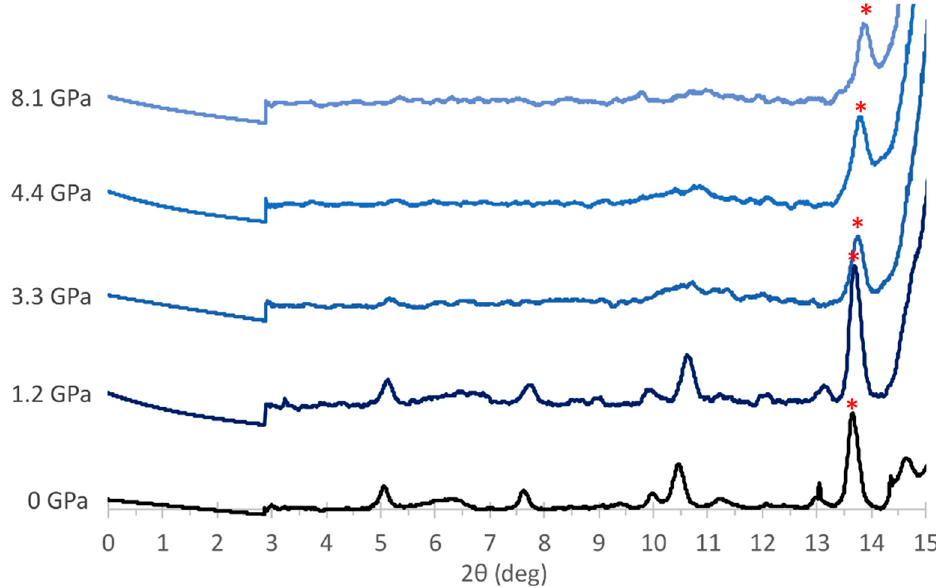
Figure 4. X-ray diffraction patterns of α -K 2 AgF 4 at increasing pressure; pressure values are labelled next to each pattern. Radiation with wavelength λ = 0.56087 Å was applied. The reflexes marked with an asterisk are derived from gold powder used as an additional pressure gauge.